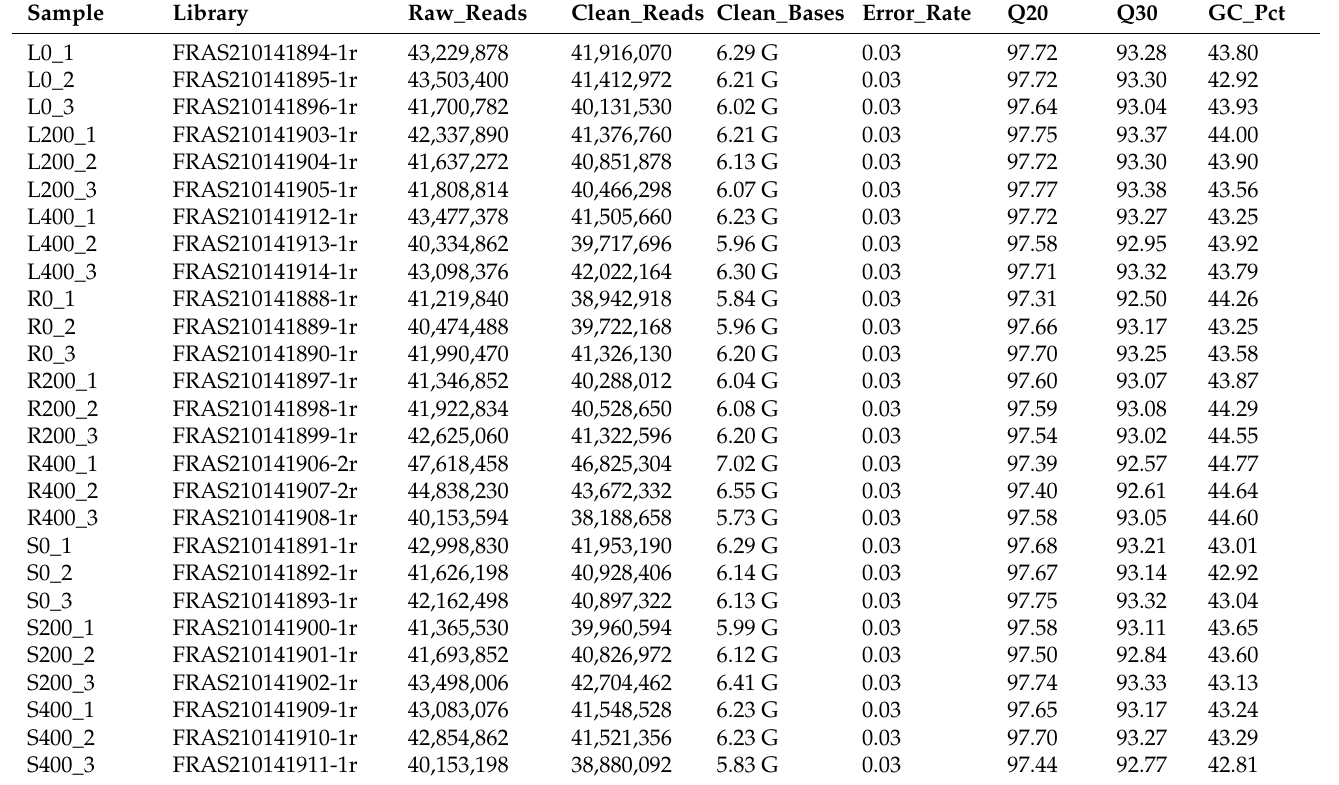
Table 1. Information of RNA-seq